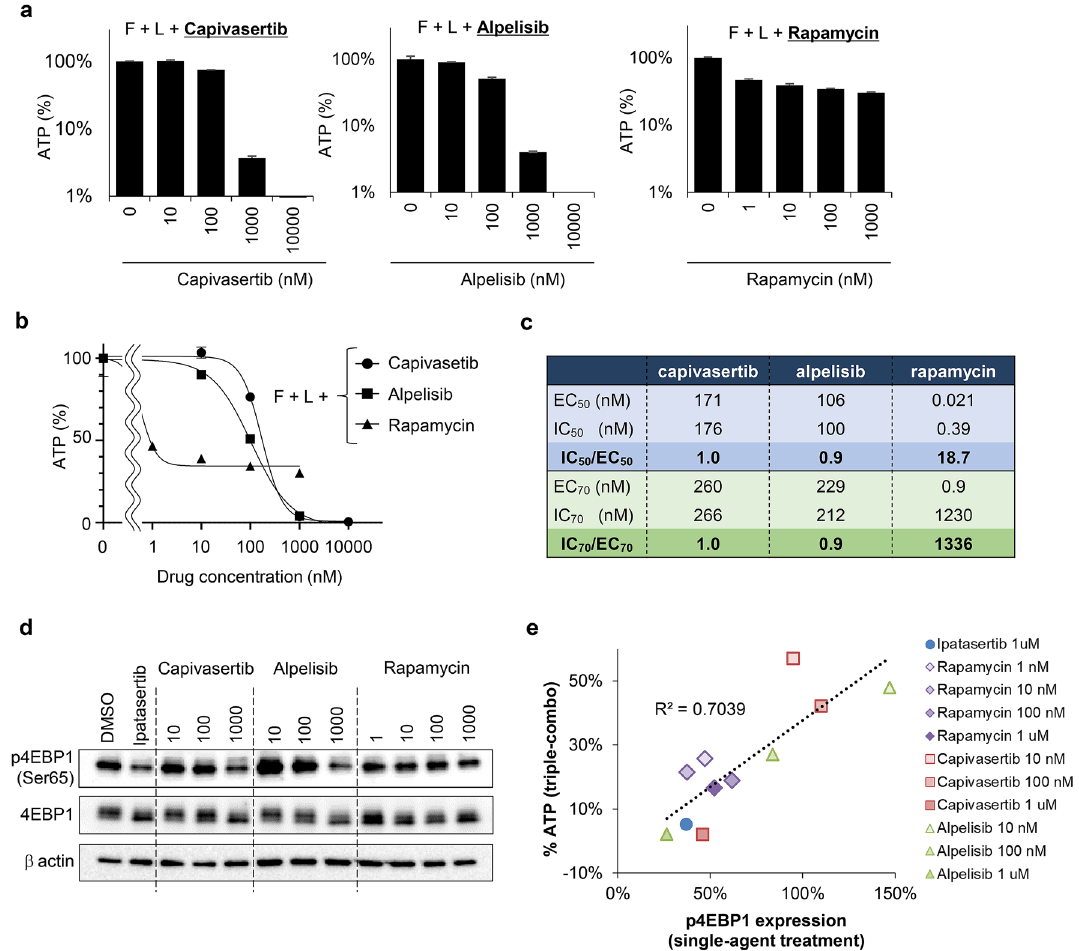
Figure 7. Phosphorylated 4EBP1 is a potential predictive biomarker for combination treatment with lapatinib and ipatasertib. ( a ) Antiproliferative activity of combination treatment with fulvestrant (100 nM), lapatinib (100 nM), and PI3K pathway inhibitors (capivasertib, alpelisib, and rapamycin) in MDA-MB-361 ( PIK3CA -mutant) cells. The cells were treated for 8 days. Relative ATP amounts were calculated using a chemiluminescence assay and compared with the chemiluminescence value of combination treatment with fulvestrant and lapatinib on day 8 (mean ± SD [n = 3]). ( b , c ) Dose response curve and EC/IC of PI3K pathway inhibitors (capivasertib, alpelisib, and rapamycin) in combination with fulvestrant (100 nM) and lapatinib (100 nM). This graph and calculation was performed by GraphPad Prism. ( d ) Inhibitory effects of Capivasertib, alpelisib, and rapamycin on 4EBP1 phosphorylation in MDA-MB-361 cells. Cells were treated with capivasertib, alpelisib, and rapamycin at the indicated concentrations for 24 h. β-actin was used as a loading control. Full-length blots are presented in Supplementary Fig. 11b. ( e ) Correlation between p4EBP1 expression and antiproliferative activity of triple treatment combinations in MDA-MB-361 cells. Cells were treated with the triple-combination of fulvestrant, lapatinib, and ipatasertib (blue), rapamycin (purple), capivasertib (red), or alpelisib (green) at the indicated concentrations for 8 days (n = 3). The X-axis indicates p4EBP1 expression in cells treated with the indicated PI3K inhibitors as monotherapy for 24 h. The Y-axis indicates relative ATP amounts (%) in the triple combinations. The relative ATP amounts were calculated using a chemiluminescence assay and compared with the chemiluminescence value of the DMSO control on day 8. p4EBP1 expression was calculated using immunoblotting data quantified by ImageJ software. F, Fulvestrant; L,